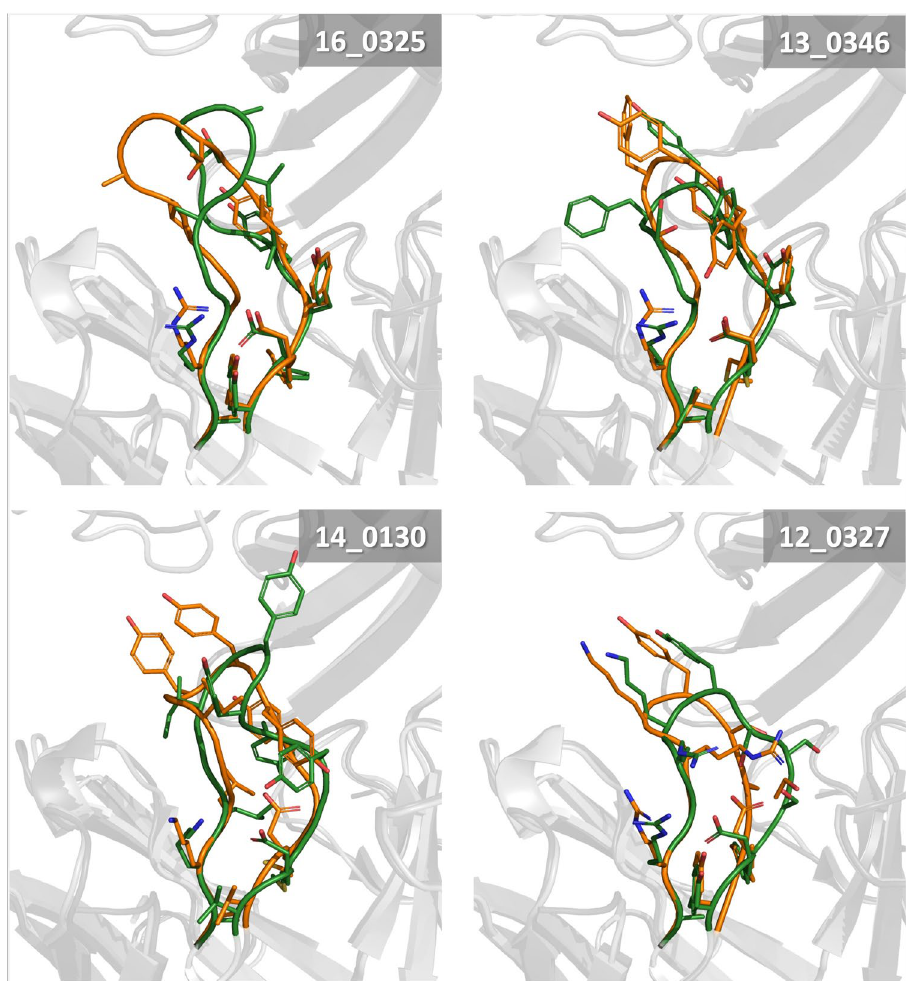
Figure 6. Structural validation of four H3 redesigns. Sequences for design IDs 16_0325, 13_0346, 14_0130 and 12_0327 are shown in Table 3. In light and dark gray are the crystal and predicted structures, respectively, for each prospective design. The experimentally observed conformation of H3 loop is shown in green. The best- scoring Talaris energy-based H3 loop conformation is shown in